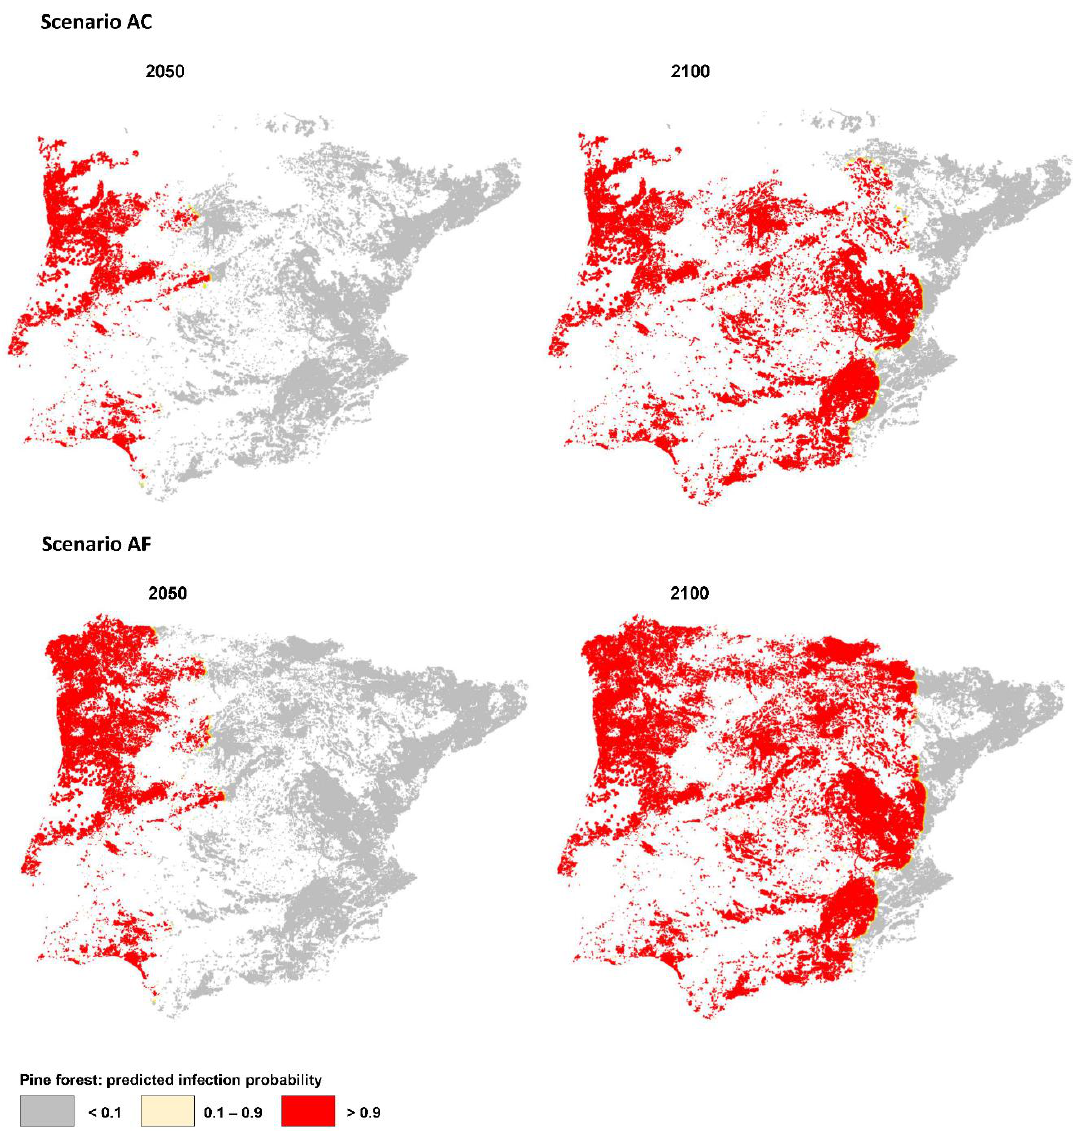
Figure 1. PWN spread in the Iberian Peninsula for the years 2050 and 2100, considering all pine tree species as susceptible of being infected. Both the current climate (Scenario AC) and future climate (Scenario AF) are considered.